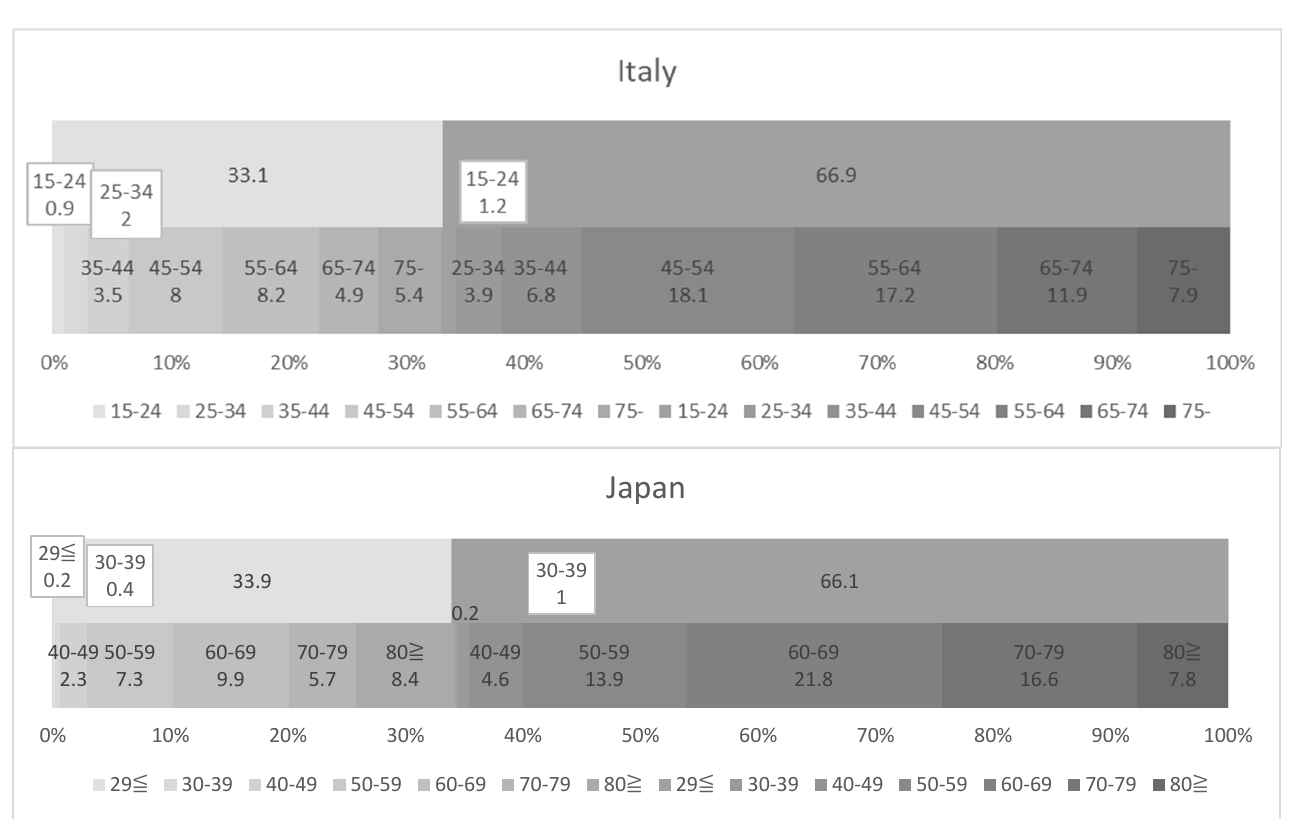
Figure 1. Gender and age group of the main caregivers in Italy and Japan. Source: [45,46].